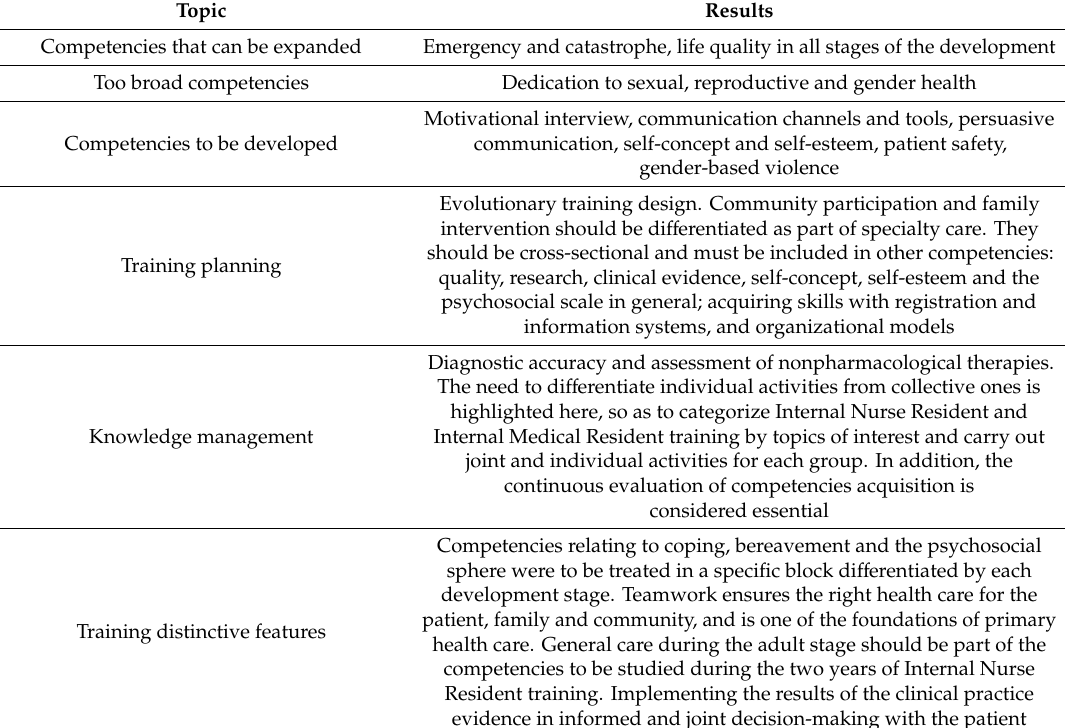
Table 1. Results from the focus group regarding the analysis of primary care nurses’